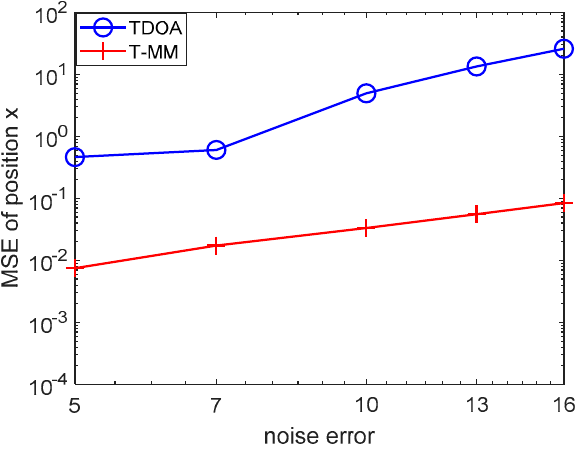
Figure 9. MSE comparison between conventional TDOA and the proposed T-MM versus measurement noise error over the bellhop underwater channel model.